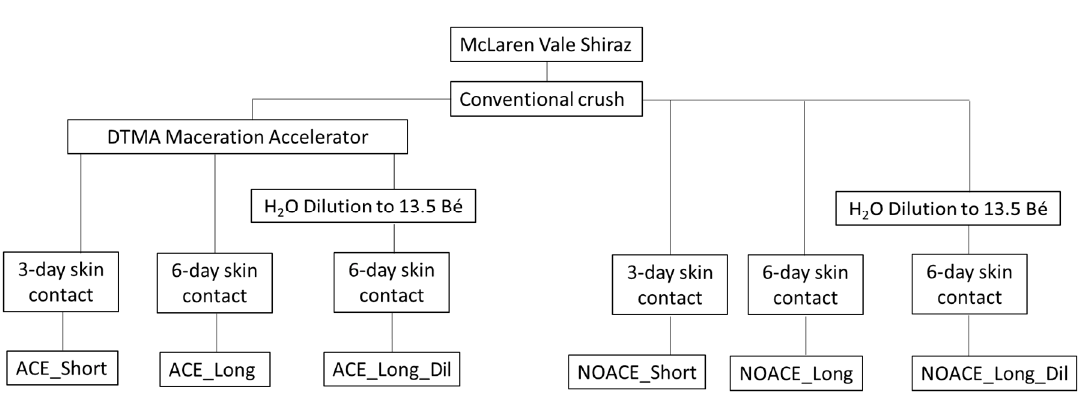
Figure 1. Summary of the treatments conducted on Shiraz musts prepared by the NOACE (conventional crush) or Accentuated Cut Edges (ACE) (conventional crush plus Della Toffola Maceration Accelerator (DTMA)) treatment, with six different treatments performed in triplicate.